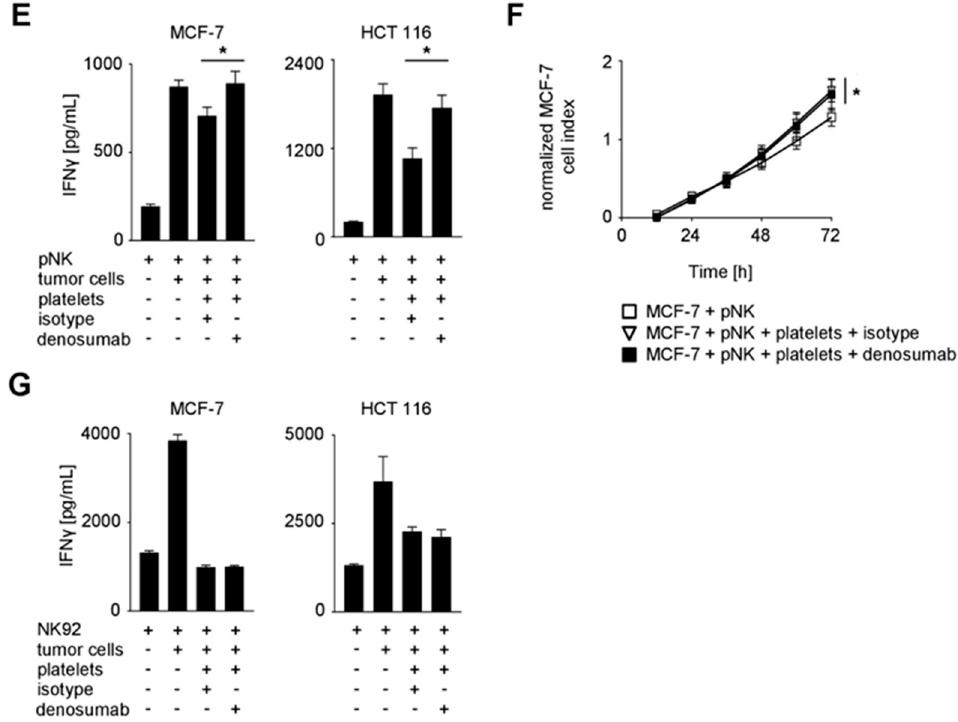
Figure 4. Functional role of platelet-derived RANKL in NK cell reactivity against solid tumors. ( A ) RANKL surface expression on the indicated tumor cells was investigated by flow cytometry. ( B–G ) The indicated tumor cells were incubated in the presence or absence of platelets from HD. Coating was performed as described in the Materials and Methods section. ( B ) RANKL and CD41a surface expression on the indicated platelet-coated tumor cells was investigated by flow cytometry. ( C ) pNK cells were cultured in the presence or absence of the indicated tumor cells and platelets from HD. IFN γ levels in the culture supernatants were determined by ELISA after 24 h. ( D ) pNK cells were co-cultured with MCF-7 cells in the presence or absence of platelets from HD. The effect of NK cell reactivity on tumor cell proliferation/survival was assessed by xCELLigence RTCA for 72 h. Results are shown as electrical impedance signal (given as normalized cell index). Cell index was normalized after addition of NK cells to the tumor cells. ( E ) pNK cells were cultured in the presence or absence of the indicated tumor cells and platelets from HD. Where denoted, denosumab (10 µ g/mL) or the respective isotype control was applied. IFN γ levels in the culture supernatants were determined by ELISA after 24 h. ( F ) pNK cells were treated as indicated in ( E ) and analyzed as in ( D ). ( G ) NK92 cells were treated and analyzed as described in ( E ). ( C – G ) Representative data of one experiment from a total of at least three with similar results are shown. Statistically significantly different results ( p < 0.05) are indicated by *.